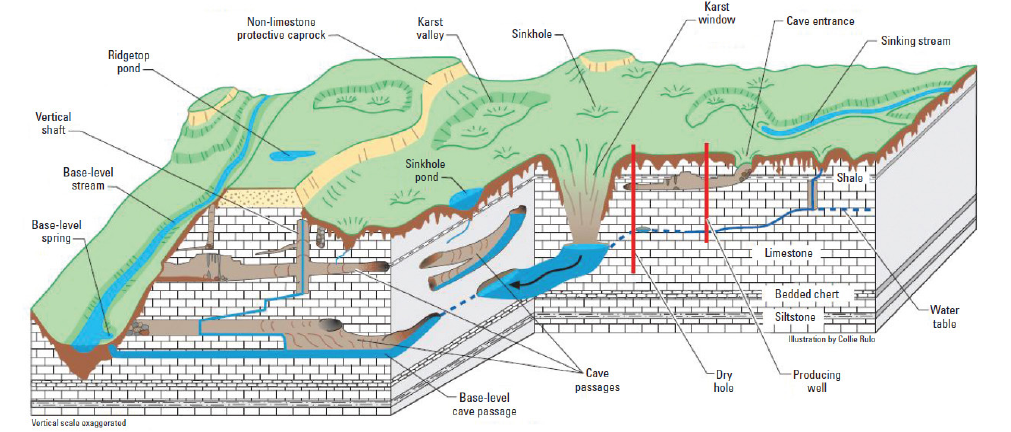
Figure 1. Karstic environment (extracted from